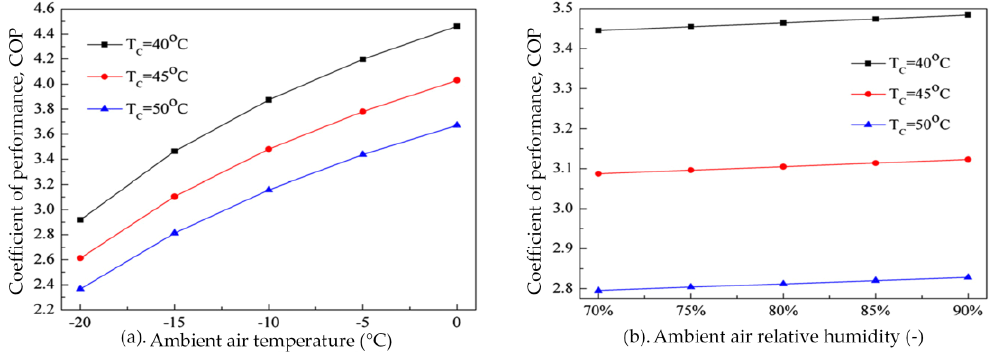
Figure 19. Effects of ambient air temperature and its RH on COP of FFASHP system [53].